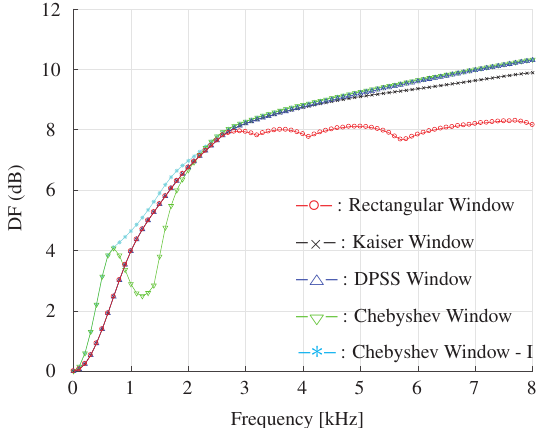
Figure 14. DF as a function of frequency for different window-based beamformers with a constant beamwidth. The beamwidth is fixed to 40 ◦ , M = 11, δ = 3.5